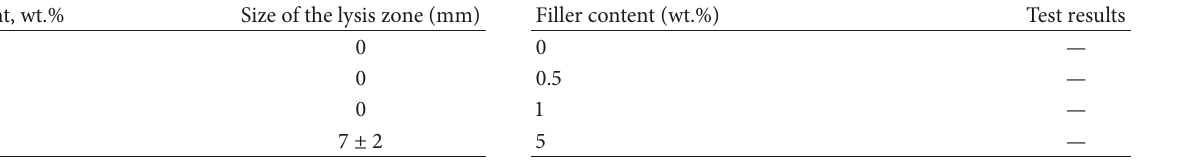
Table 6: Antibacterial activity of the HEC/organobentonite com- posite films against S. aureus. Filler content, wt.%